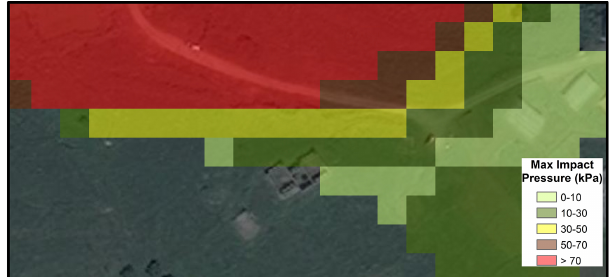
Fig. 12. Damaged school during 1981 avalanche; impact pressure forces of around